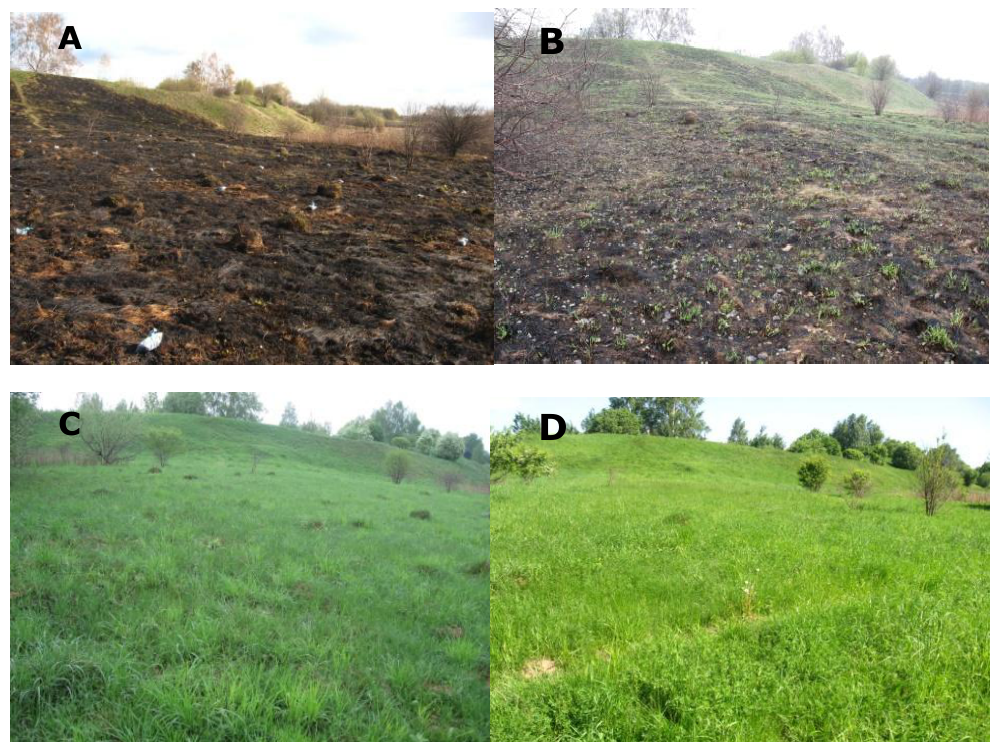
Fig. 8. From left to right and up down. View of the study site 4, 16, 34 and 45 days after the fire. 6